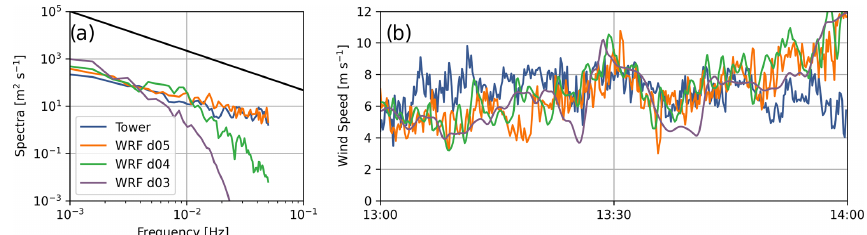
Figure A1. Comparison of (a) time series and (b) spectra between SW_TSE04 tower data and WRF–LES–GAD d05 ( (cid:49)x = 10m), d04 ( (cid:49)x = 50m), and d03 ( (cid:49)x = 150m) for 80m wind speed at SW_TSE04 for the convective case study. The − 5 / 3 inertial subrange power law is provided in black for reference. Note that the model wind speed is output at 10s intervals; therefore, the highest resolvable frequency with this time series is 0.05Hz.